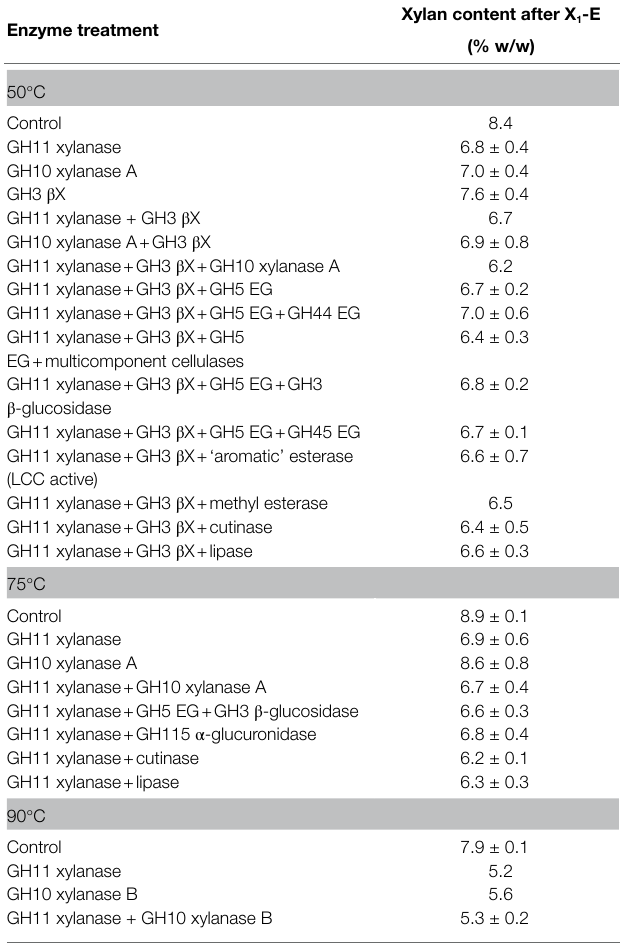
TABLE 2 | Effect of X 0 -D 0 -HCE-X 1 -HCE treatment on the xylan content of oxygen-delignified (ODL) kraft paper-grade pulp. * Treatment